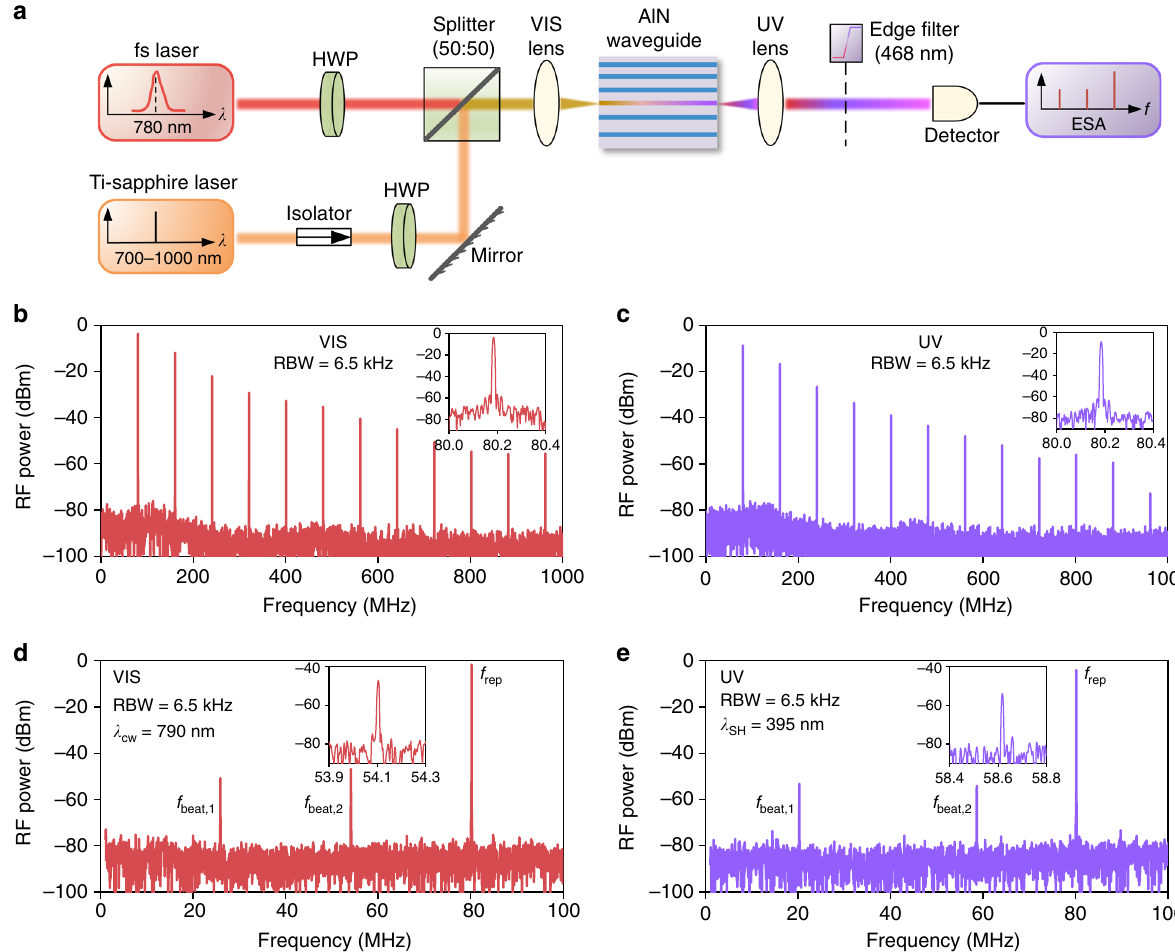
Fig. 4 Coherence characterization. a Illustrated experimental setup for characterizing heterodyne beatnotes of near-VIS and UV supercontinuum microcombs. The fs and reference Ti-sapphire lasers are combined by a cube beamsplitter and delivered into the AlN chip. The outgoing lights are then sent into a low-noise UV-sensitive photodetector (Newport 1801, 320 – 1000 nm) followed by an electrical spectrum analyzer (ESA). b and c Radio- frequency (RF) spectra of free-space near-VIS (attenuated) and UV combs at a resolution bandwidth (RBW) of 6.5 kHz when the Ti-sapphire laser is off. The decreasing RF power with the frequency is induced by the limited detector bandwidth of 125 MHz. Insets in ( b ) and ( c ): zoom-in near-VIS and UV repetition rates around 80 MHz. d and e Heterodyne beatnotes of free-space near-VIS (attenuated) and UV microcombs (RBW of 6.5 kHz) when the fs and Ti-sapphire lasers are on. Here we lock the Ti-sapphire laser at λ cw = 790 nm using a high-resolution wavemeter and obtain the SH UV laser at λ SH = 395 nm with the free-space power above 10 μ W. Insets in ( d ) and ( e ): zoom-in near-VIS and UV heterodyne beatnotes around f beat,2 with short-term